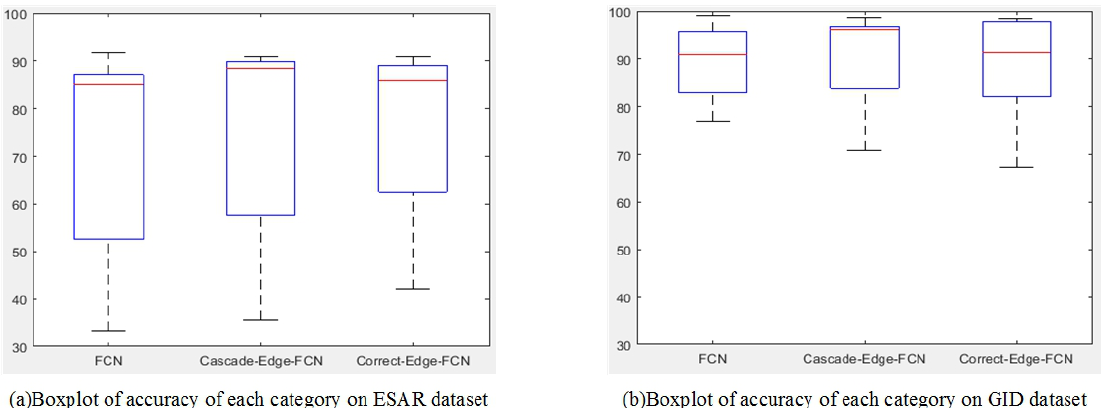
Figure 13. Boxplots of ESAR dataset and GID dataset.